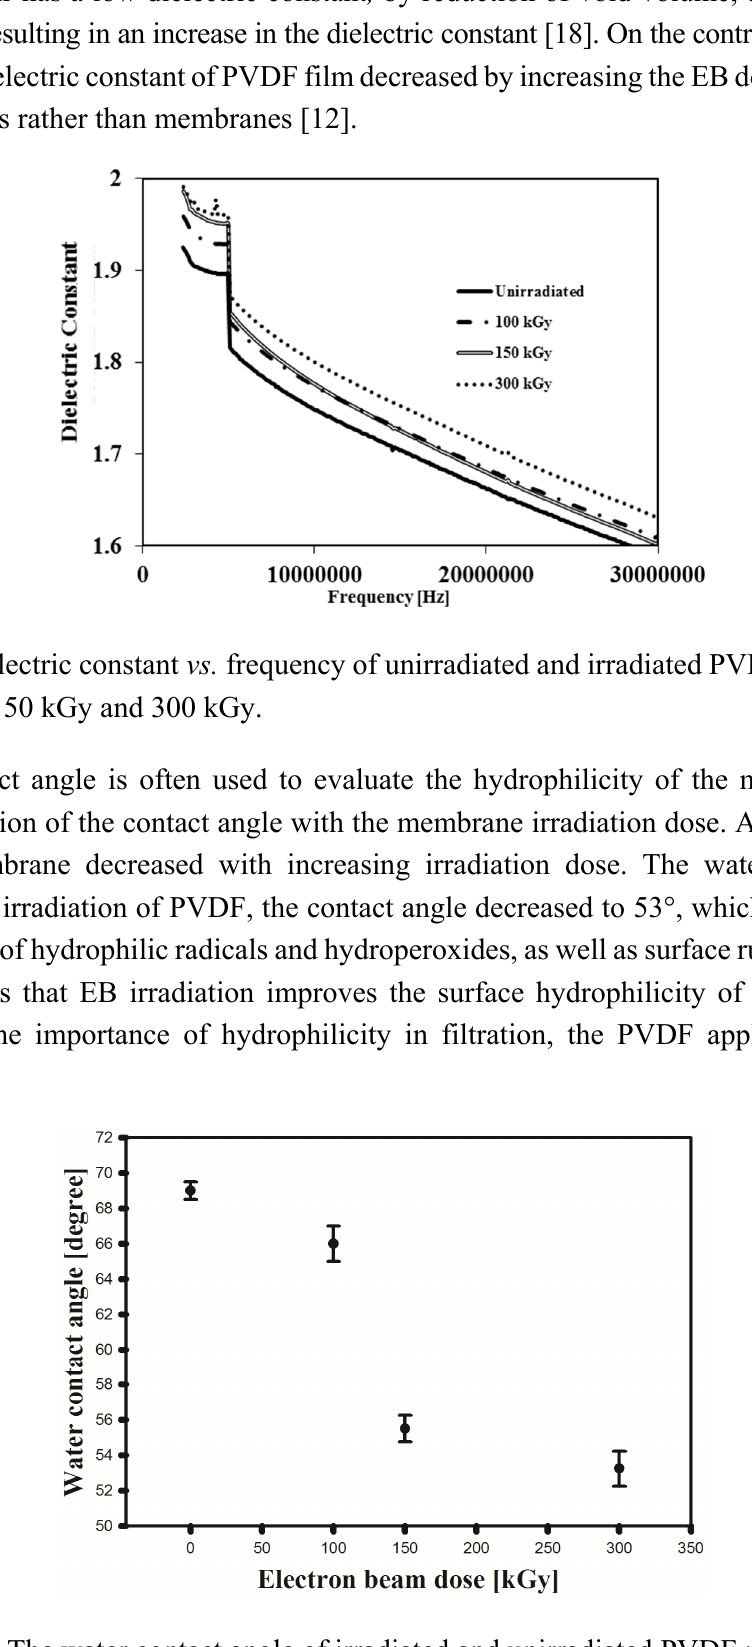
Figure 6. The water contact angle of irradiated and unirradiated PVDF